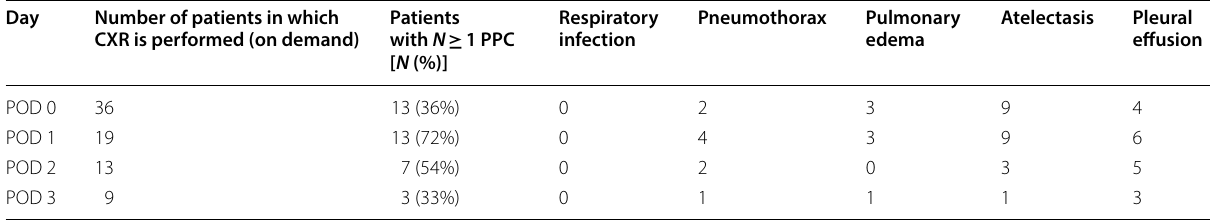
Patients can develop multiple PPCs. Total amount of PPCs can be higher than the number of